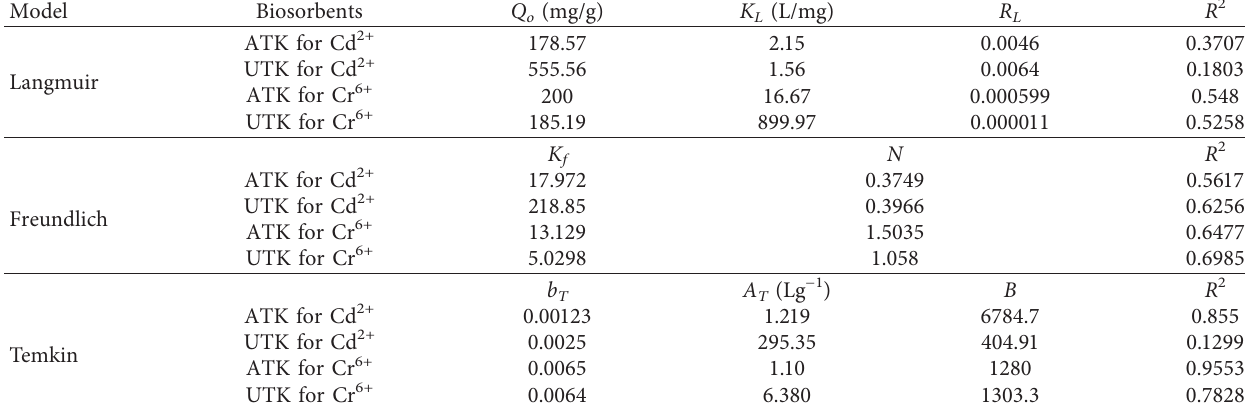
Table 3: Evaluated parameters of Langmuir, Freundlich, and Temkin isotherms for Cd (II) and Cr (VI) metal ion biosorption onto ATK and